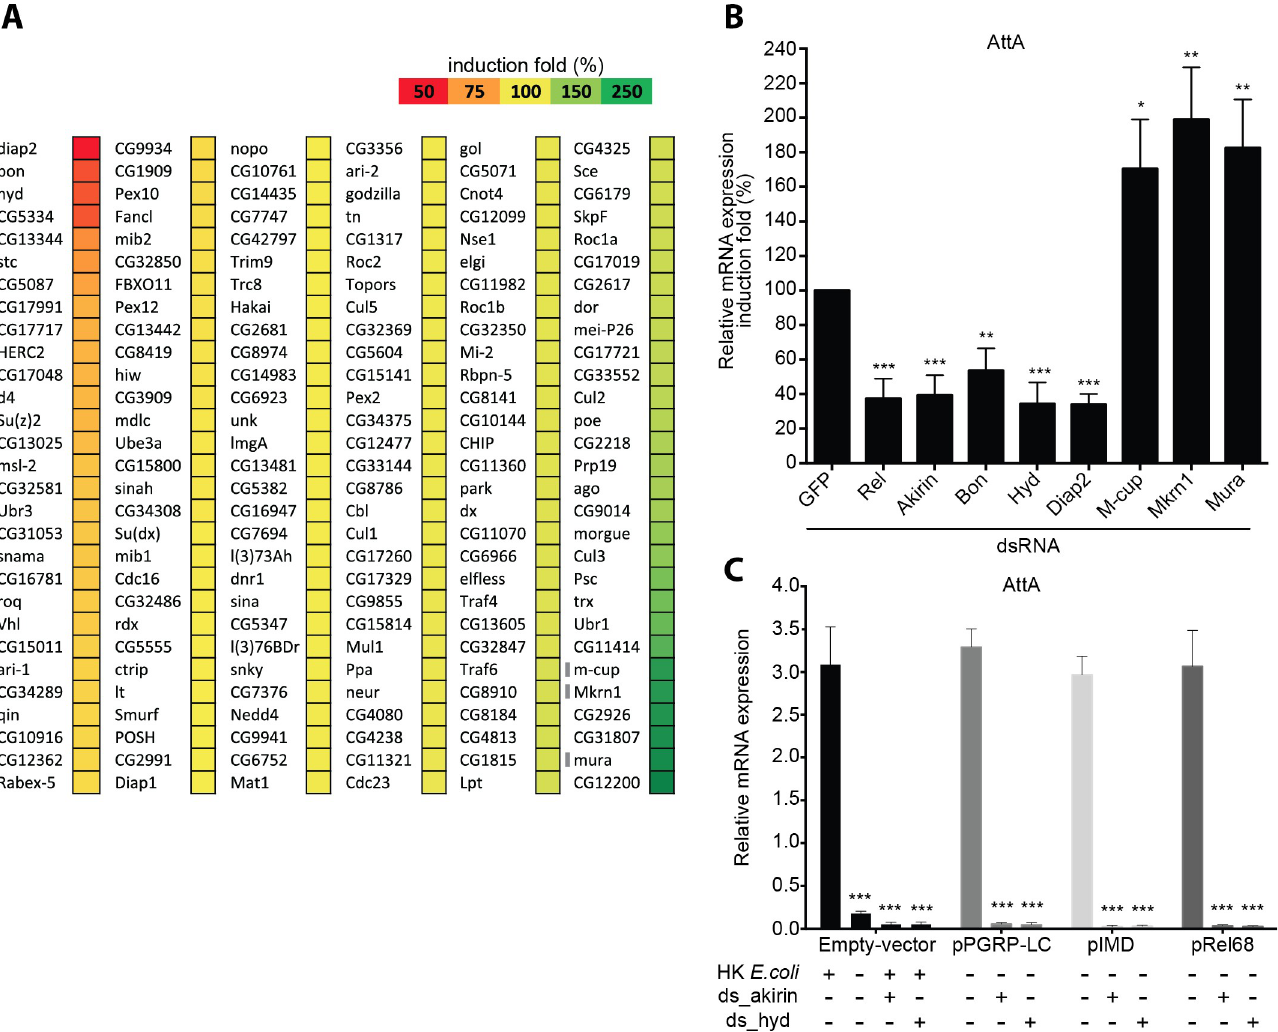
Fig 1. E3-ubiquitin ligases screen identified in vitro Hyd as involved in IMD pathway. ( A ) Induction of the IMD pathway measured by luciferase activity. 174 Drosophila E3 ubiquitin ligases were knocked down in S2 cells harboring the Attacin-A–luciferase reporter gene. Cells were transfected with individual dsRNAs targeting each E3 ligase before the IMD pathway was induced by stimulating the cells with heat-killed E . coli (HKE). Luciferase activity is expressed as an induction percentage compared to control cells treated with dsRNA targeting GFP . Three independent experiments were performed. Genes indicated by a gray bar were analyzed in Fig 1B. ( B ) Quantitative RT-PCR of Attacin-A mRNA from HKE-stimulated S2 cells transfected with dsRNA targeting GFP (negative control), Relish or Akirin (positive controls), and a subset of E3 ubiquitin ligases. After the ratio of stimulated over unstimulated values for each condition was determined, statistical significance was calculated by comparing genes knockdown to GFP dsRNA control. ( C ) Genetic epistasis experiment to place Hyd within the IMD pathway in S2 cells. The IMD pathway was induced by HKE stimulation or by transfecting the cells with Pgrp-LC , Imd-V5 , or Rel-HA expressing plasmids. Cells were also transfected with dsRNA targeting Akirin or Hyd . Statistical significance was established by comparing values from the different conditions with cells treated with empty vector alone. Data are represented as mean ± standard deviation of three independent experiments (B-C). � P-value < 0.05; �� P-value < 0.01; ��� P-value < 0.001.